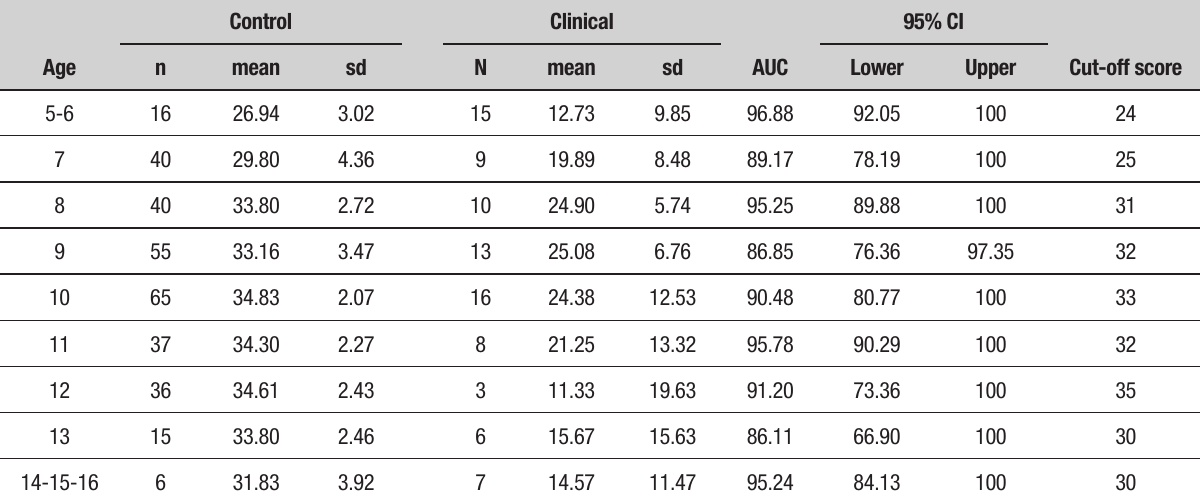
Table 4. Mean scores, AUC and cut-off values for each age level.